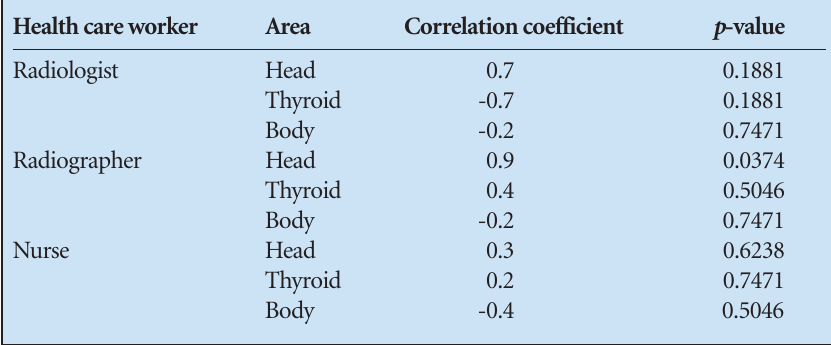
Table I.Correlation between TLD and DAP